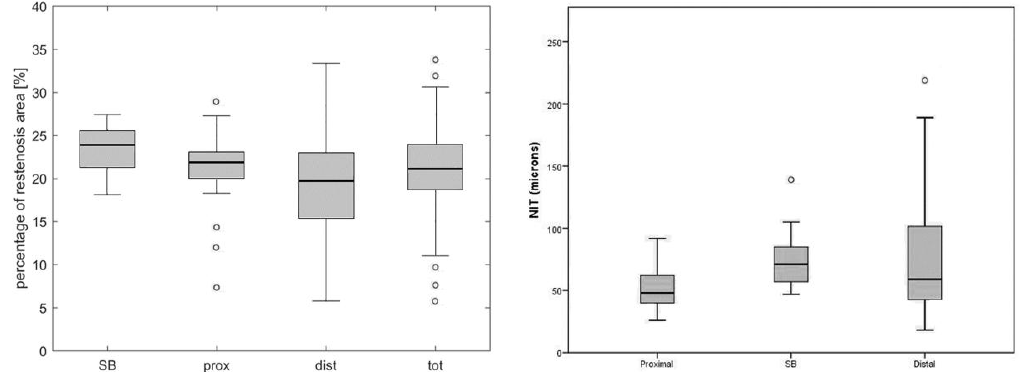
Figure 7. Boxplots of the computed percentage of restenosis area ( left ) and neo-intimal thickening ( right ) grouped according to the position. Results were grouped in side branch (SB), scaffolded proximal (prox) and distal (dist) regions, as well as the percentage of restenosis area was reported also for the entire scaffolded region (tot).